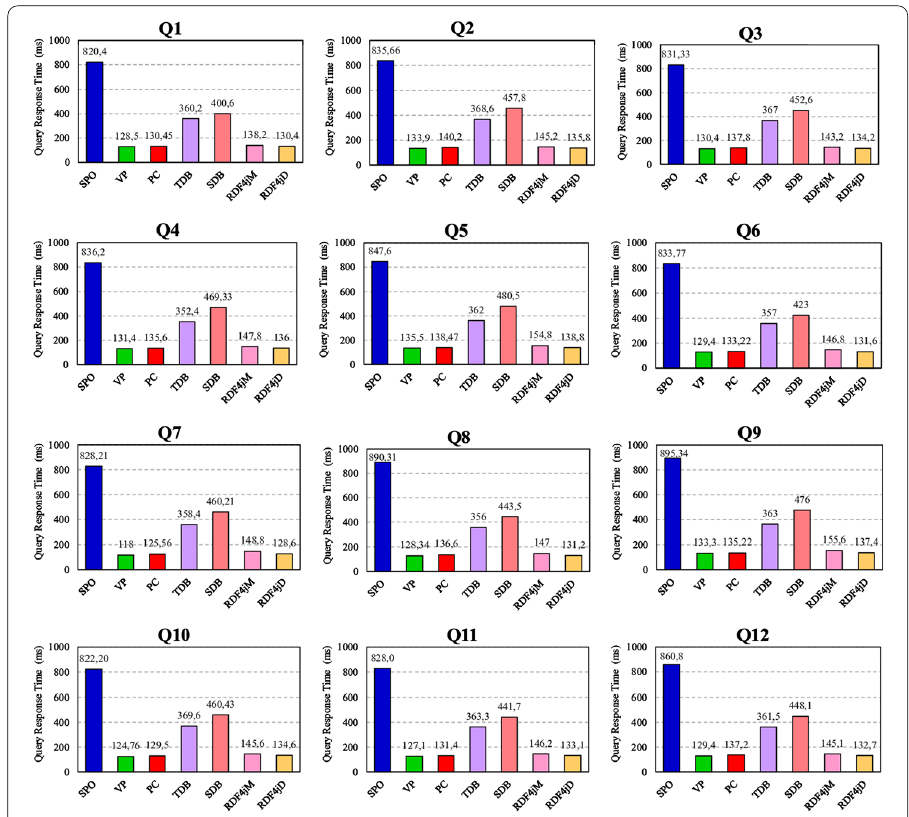
Fig. 7 Query response time comparison between the proposed methods and existing